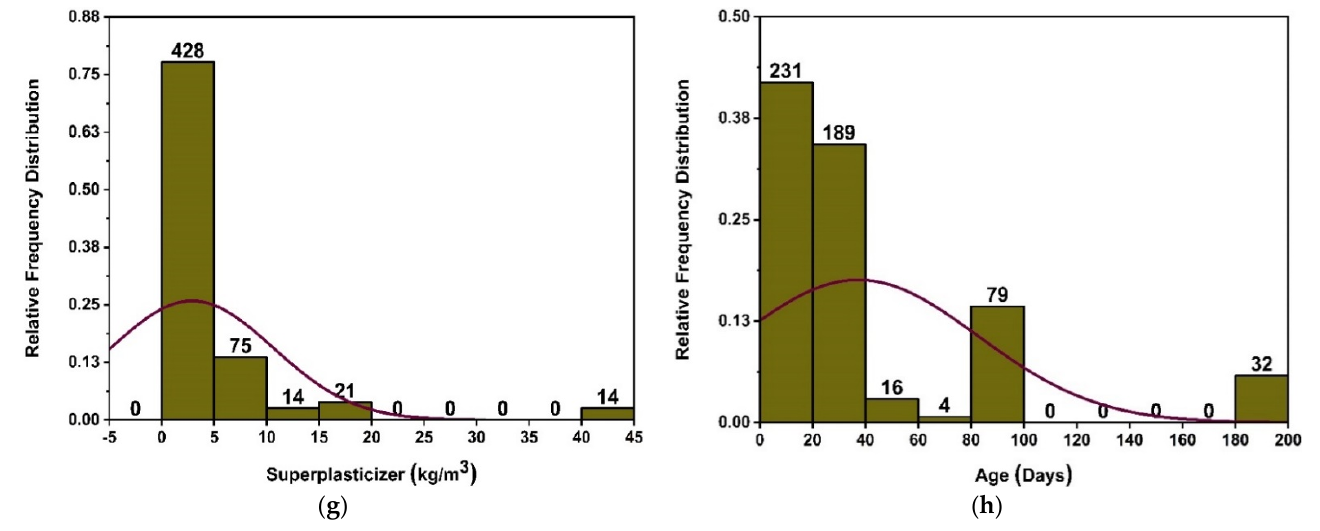
Figure 2. Compressive strength parameters’ relative frequency distribution; ( a ) cement, ( b ) fine aggregate, ( c ) coarse aggregate, ( d ) water, ( e ) silica fume, ( f ) metakaolin, ( g ) superplasticizer, and ( h ) age.